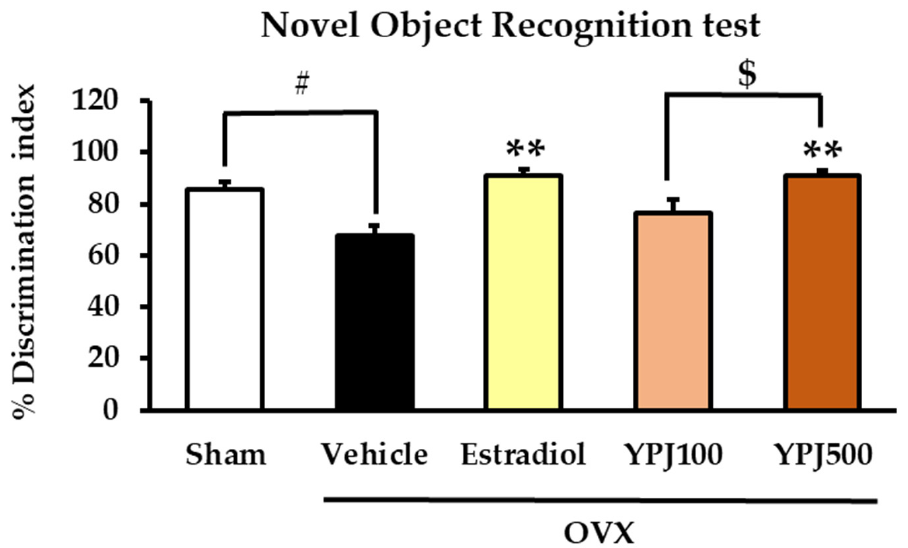
Figure 2. The effect of the YPJ formula on object recognition memory in the NORT. Percentage of discrimination index values in each experimental group are expressed as the mean ± SEM ( n = 10). # p < 0.05 vs. the sham group. ** p < 0.01 vs. the vehicle-treated OVX group. $ p < 0.05 between YPJ treatment (post hoc Tukey test).